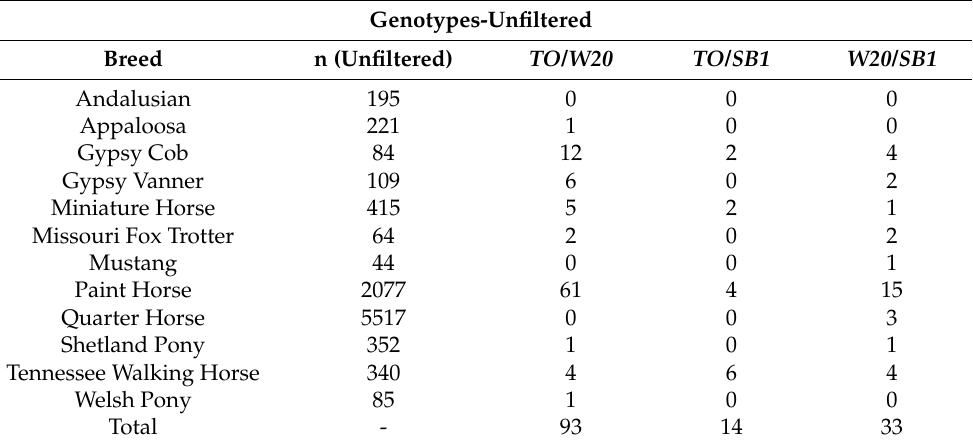
Table 4. Breed, number of individuals tested (n), and respective number of samples identified with multiple variants at the KIT locus.